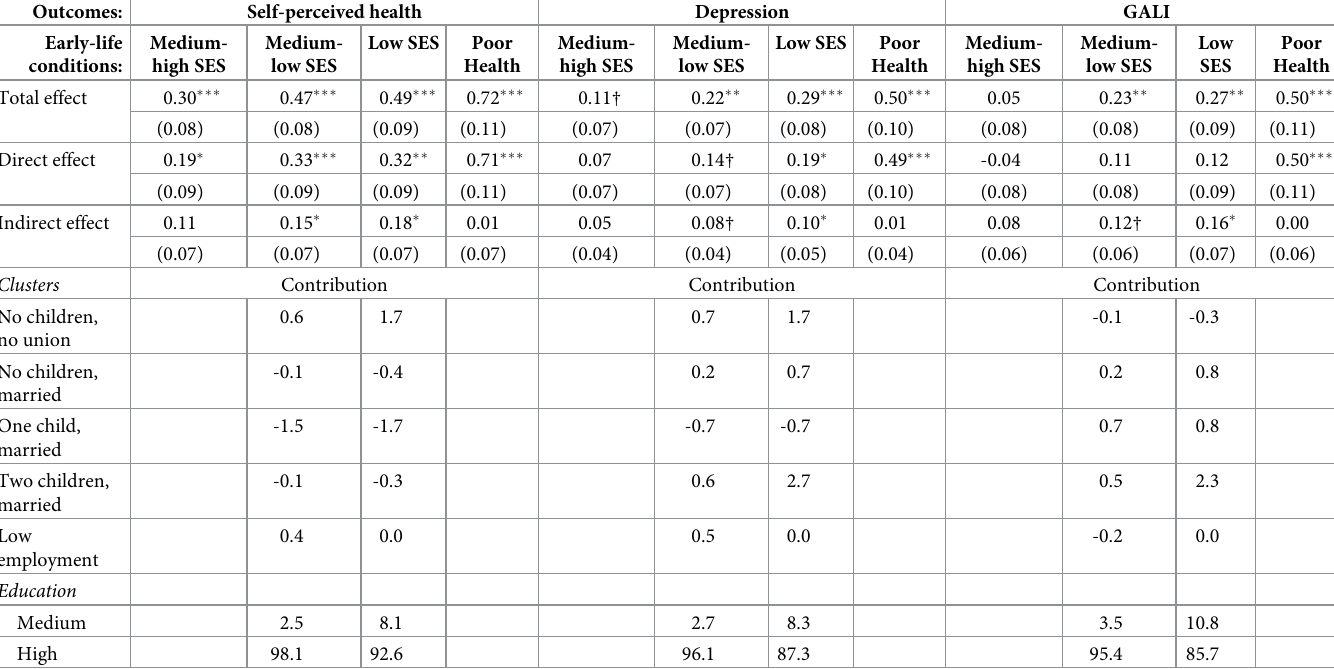
Table 2. Estimated linear and logistic regression coefficients (standard errors in parentheses) of SES and Health at 10 (early-life conditions) on three measures of health and mediating effect of life course trajectories and education. Men. (N = 5,813). Outcomes: Early-life